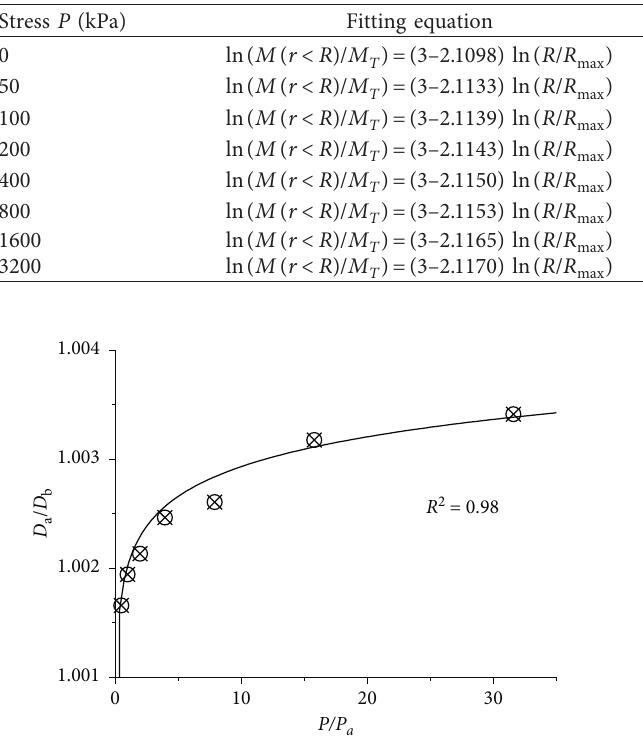
Figure 7: Linear fitting curves for ( D )